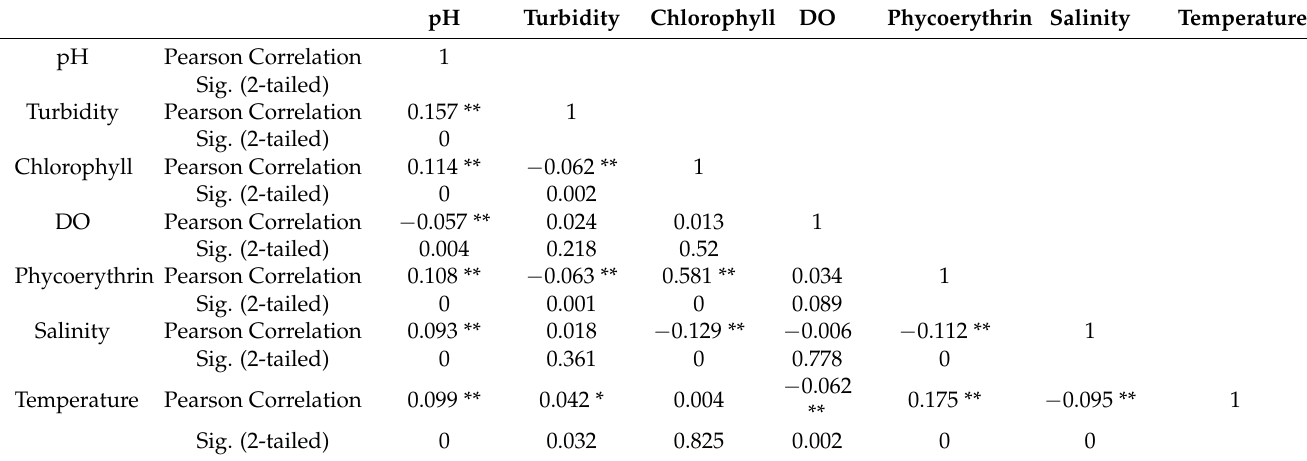
Table 7. Pearson correlation matrix based on MT region.